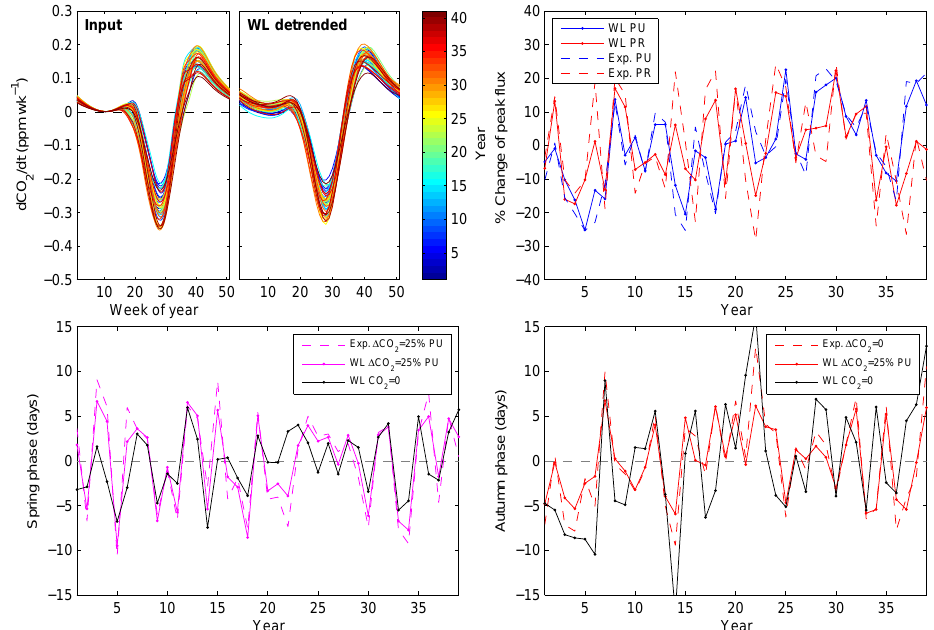
Figure B5. Same as Fig. B2 but introducing simultaneous trends in spring and autumn phase and in the peak amplitude and release of CO 2 . We also superimpose Gaussian random noise to describe interannual